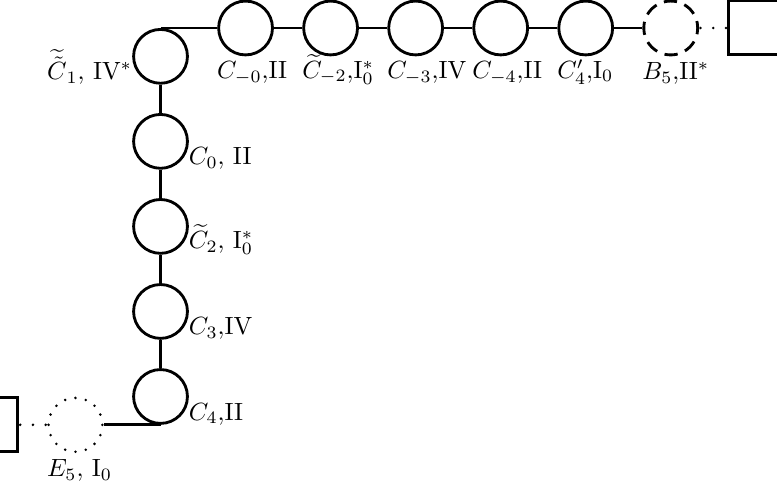
Figure 15. Full resolution of the k = 5 case. The local supporting gauge group, seen from z ’ 0 is determined by self-intersection except the rightmost node B 5 . Also the singularity on B 5 and (cid:27) 1 does not collide to enhance the